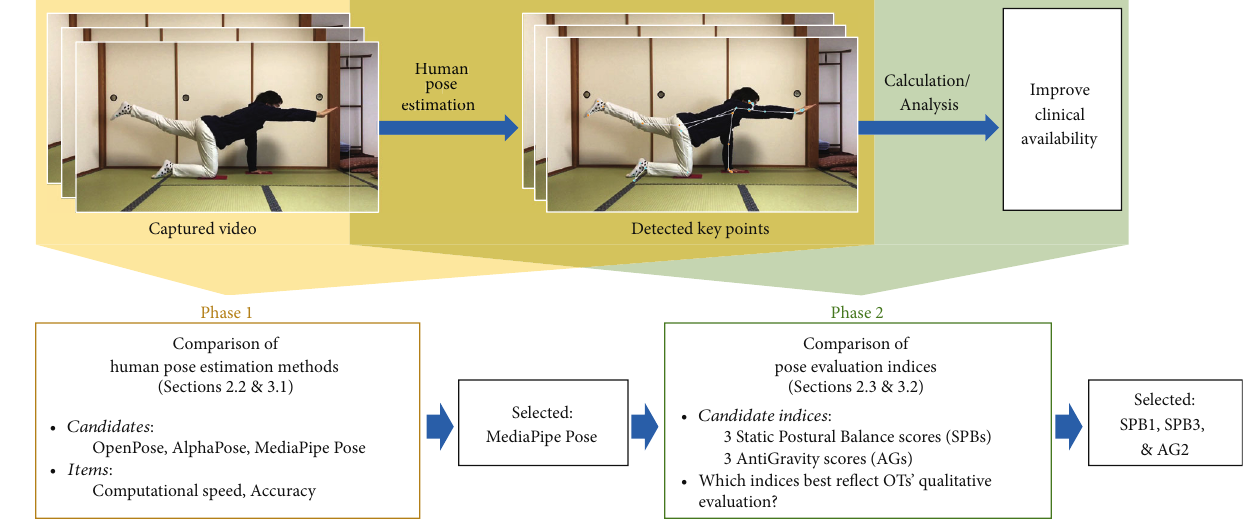
Figure 1: Flowchart of this